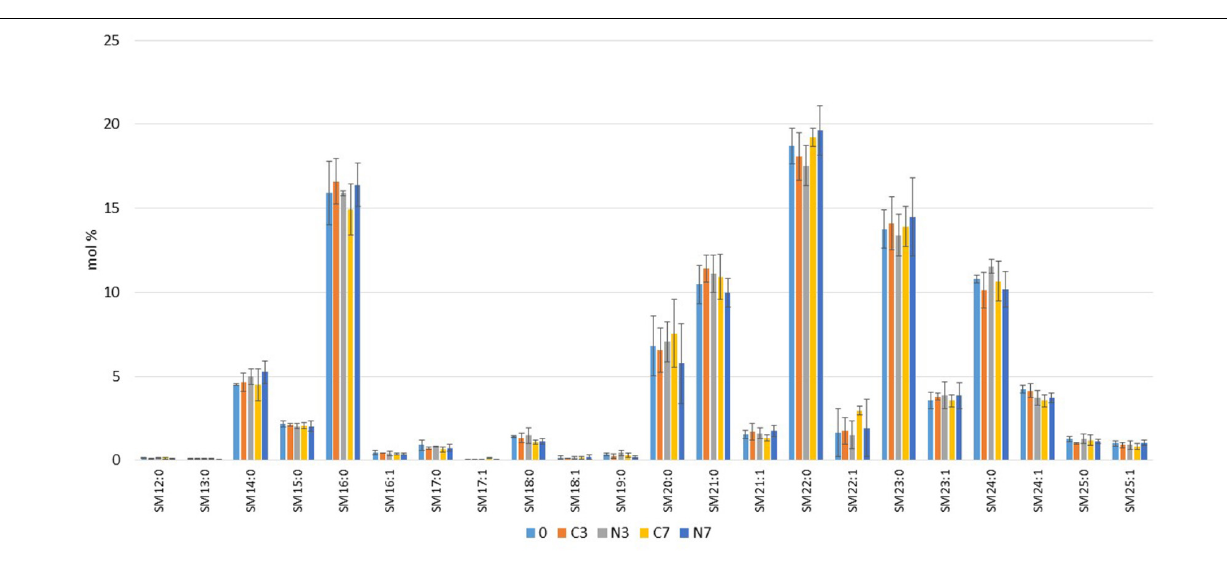
FIGURE 4 | Comparison of molecular species of sphingomyelins (SMs) detected in bovine raw milk samples (M1, M2, and M3) (in mol%) at the initial stage (0) and after 3 and 7 days in cold-stored while N 2 -flushed milk (N3, N7) compared to the only cold-stored controls (C3,